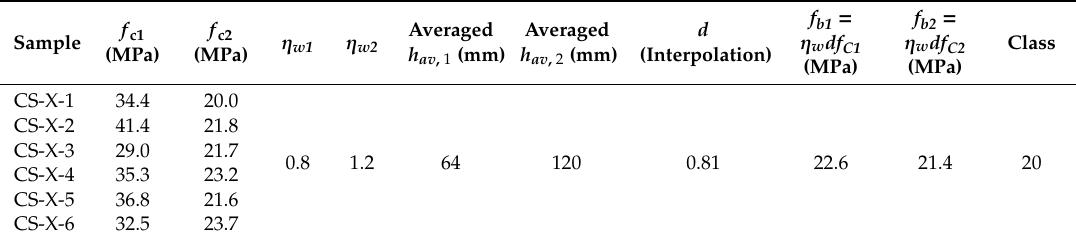
Table 5. The results obtained from the compressive strength tests carried out on the CS-X specimens used to convert to the strength class of the product.